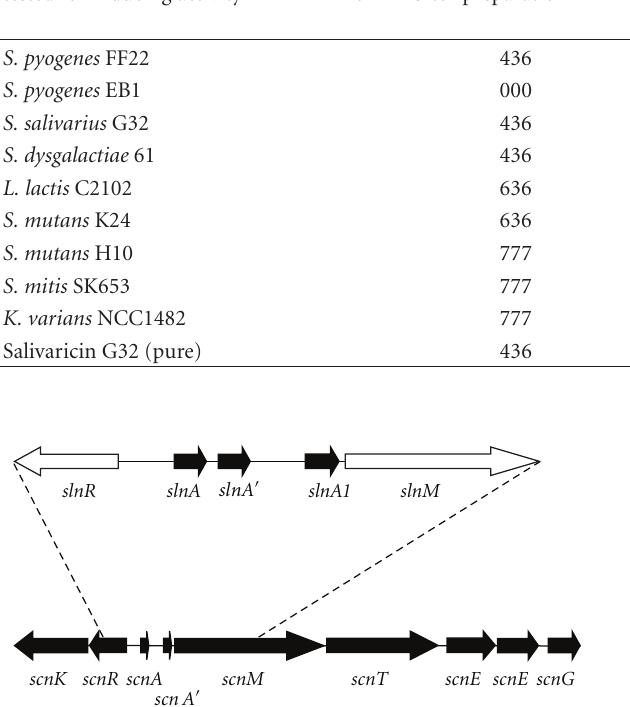
Table 4: Screen of extracts for their potential to induce inhibitor production by members of the SA-FF22 family. Inhibitor-positive preparation tested for inducing activity